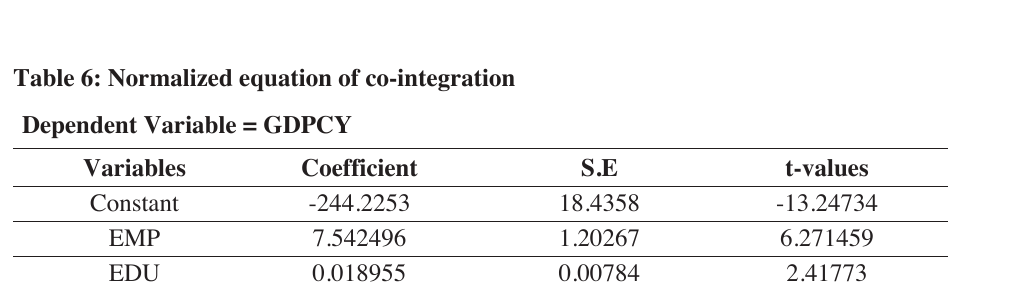
These results, represented in equation form are given